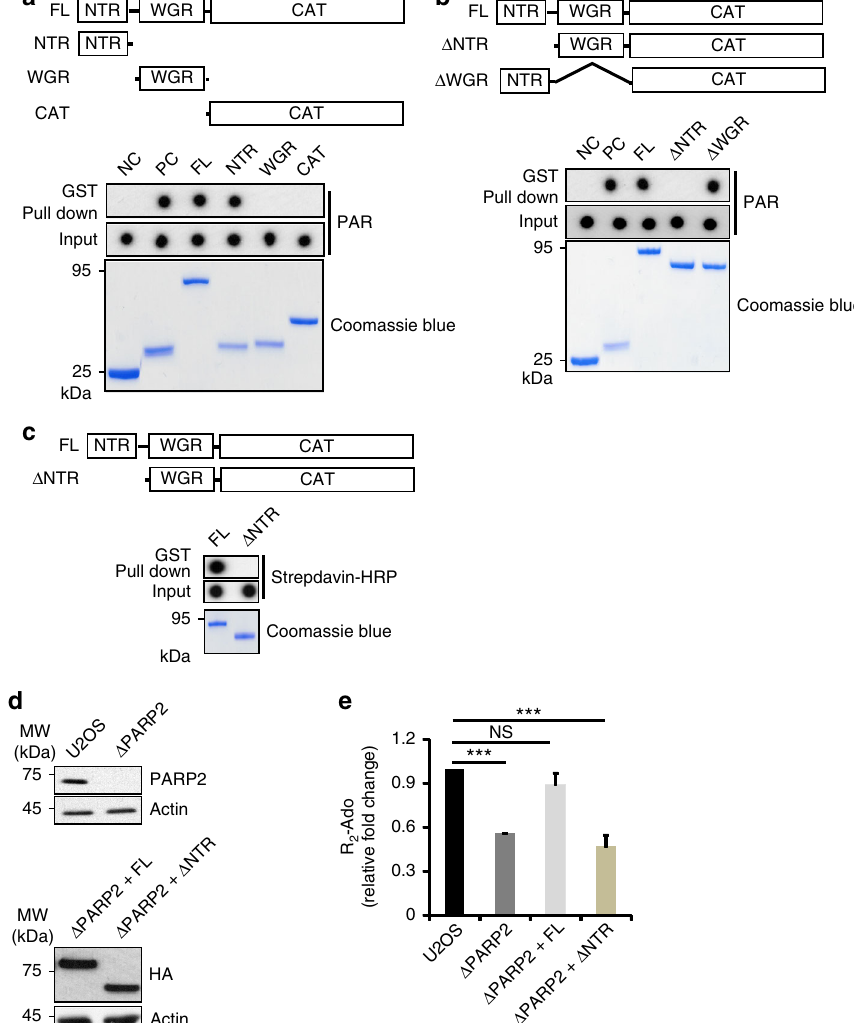
Fig. 3 N-terminus of PARP2 mediates the branched PAR chain formation. a The NTR domain of PARP2 recognizes PAR. The recombinant GST fusion proteins were incubated with 32 P labeled PAR. Protein-PAR complex was pulled down by glutathione agarose beads followed by autoradiography (top panel). Recombinant GST and GST-RNF146 WWE domain were used as the negative and positive controls (NC and PC), respectively. The GST fusion proteins were also examined by the SDS-PAGE followed with Coomassie blue staining (bottom panel). b The NTR region of PARP2 is required for the interaction with PAR. Full length PARP2, Δ NTR or Δ WGR were incubated with 32 P labeled PAR. Associated PAR was examined (top panel). Recombinant PARP2 was stained with Coomassie blue (bottom panel). c The NTR domain is required for the activation of PARP2. Biotin-NAD + was used in the in vitro PARP2-dependent PARylation assays. PARP2-dependent PARylation was examined by dot blot using streptavidin-HRP. The proteins were also examined by the SDS-PAGE followed with Coomassie blue staining (bottom panel). d The levels of PARP2 in U2OS and PARP2-null cells were examined by western blot (upper panel). The PARP2-null cells were reconstituted with full length PARP2 or the Δ NTR mutant. And their expression was con fi rmed by western blot (lower panel). e The NTR domain is required for the branched PAR chain synthesis in response to DNA damage. Cells were treated with 500 μ M H 2 O 2 for 10 min. PAR was extracted and processed by PPase and AP. R 2 -Ado was quanti fi ed by LC – MS/MS examination. Data are represented as mean ± s.d. as indicated from three independent experiments. Signi fi cance of differences was evaluated by Student ’ s t -test. NS: non signi fi cant; ***statistically signi fi cant ( p <